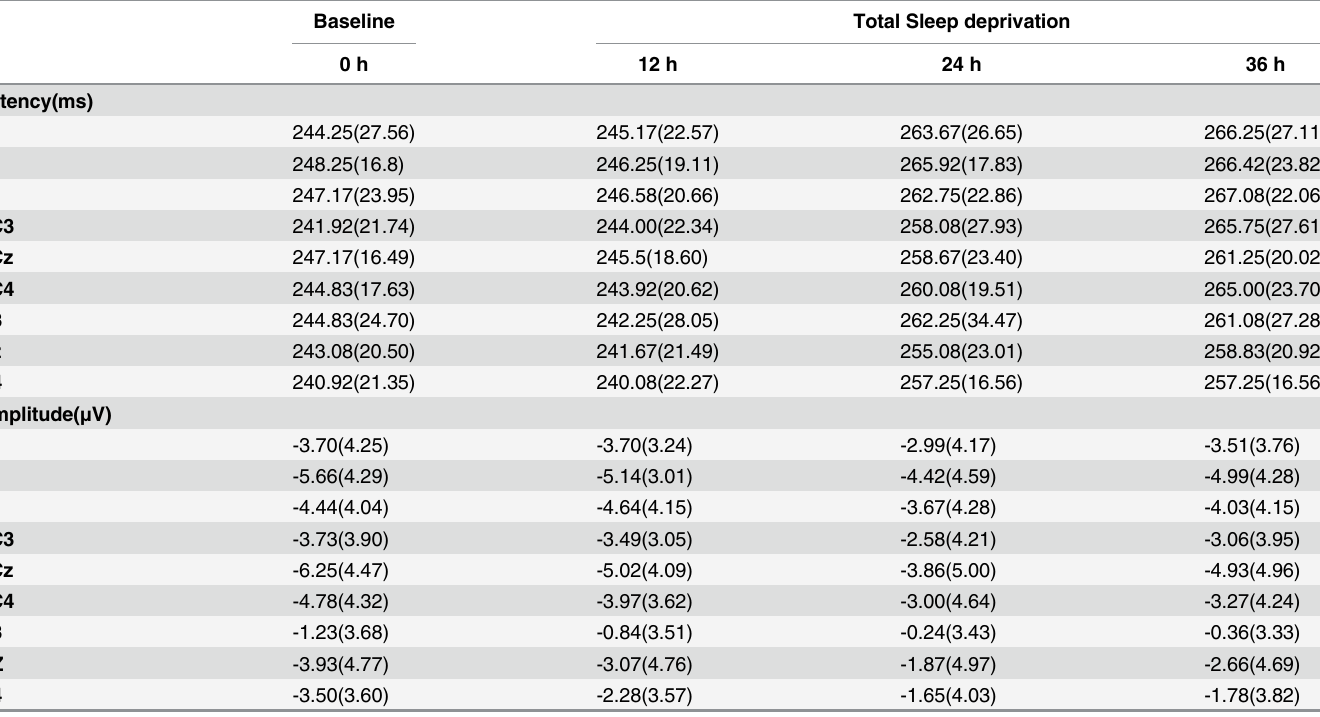
Table 2. Average NoGo-N2 Latencies and Amplitudes at F3, Fz, F4, FC3, FCz, FC4, C3, CZ, and C4 after Different Lengths of Total Sleep Deprivation.